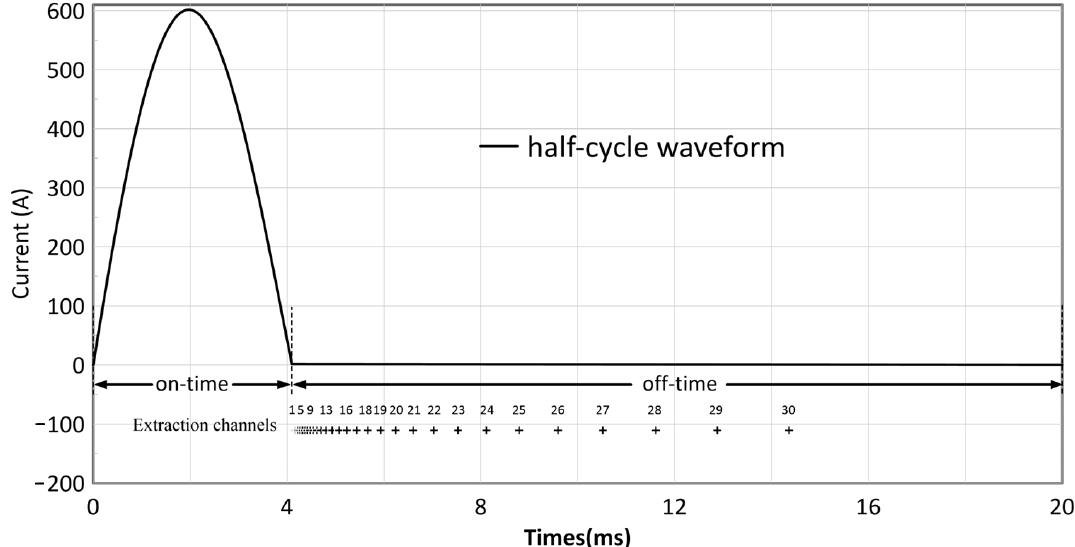
Figure 3. Half-period transmitter waveform of iFTEM-I. The plus symbols below off-time line are the gate centers of extraction windows.